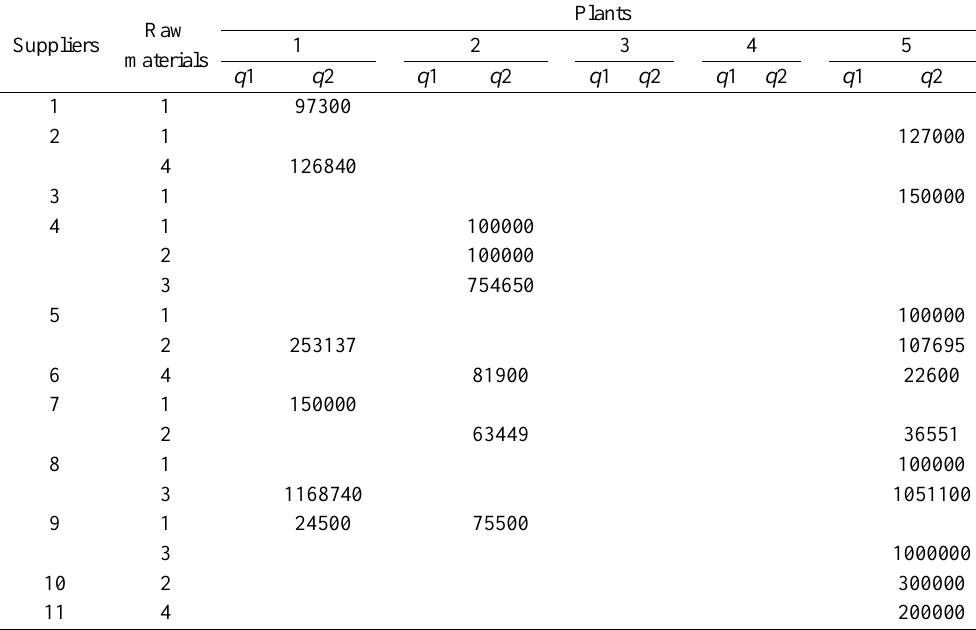
Table 14. Supplier selection and order